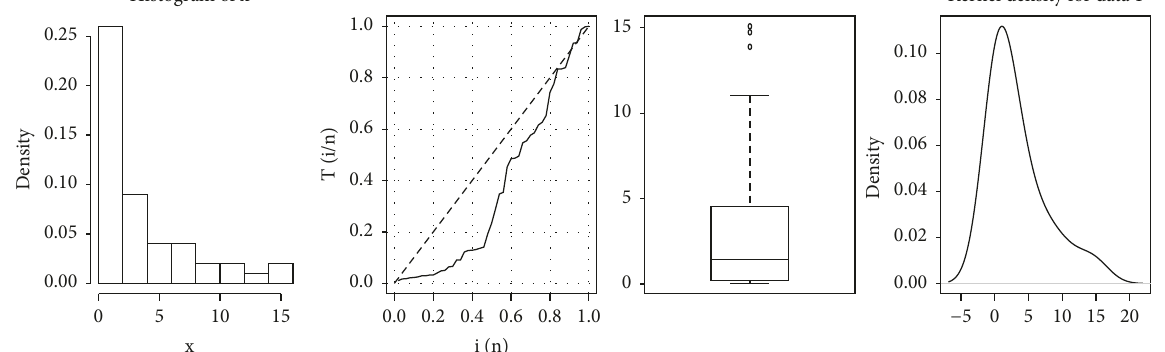
Figure 6: Histogram, TTT plot, box plot, and kernel density for failure time data.